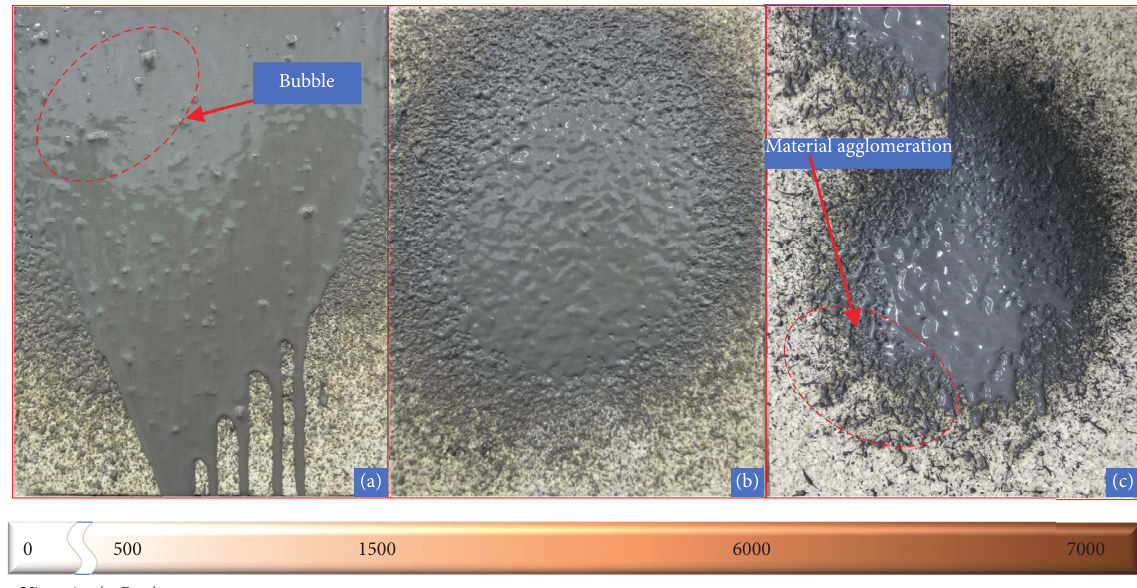
Figure 5: Typical spray effect diagram.